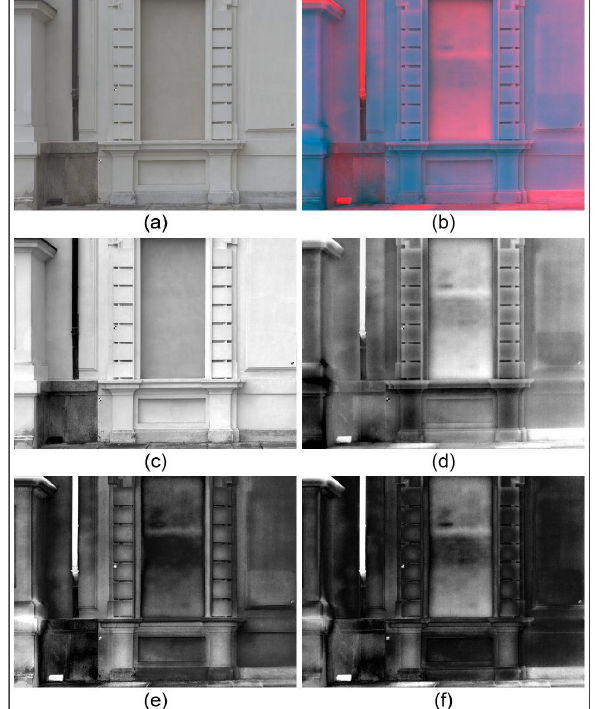
Figure 5. Castello del Valentino west façade multiband results: (a) cropped VIS image; (b) TIR-NIR-red false-color composite; (c,d) principal component analysis–first and second component; (e,f) Fourier transform.